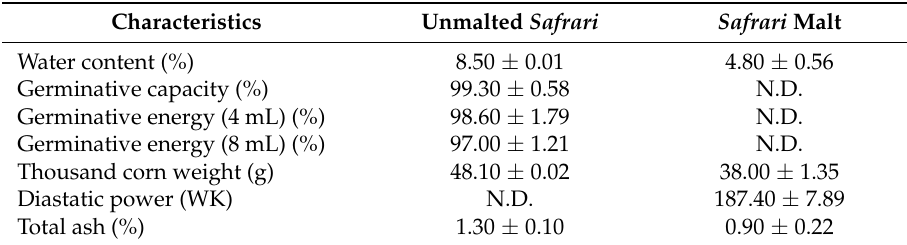
Table 4. Physicochemical characteristics of unmalted and malted